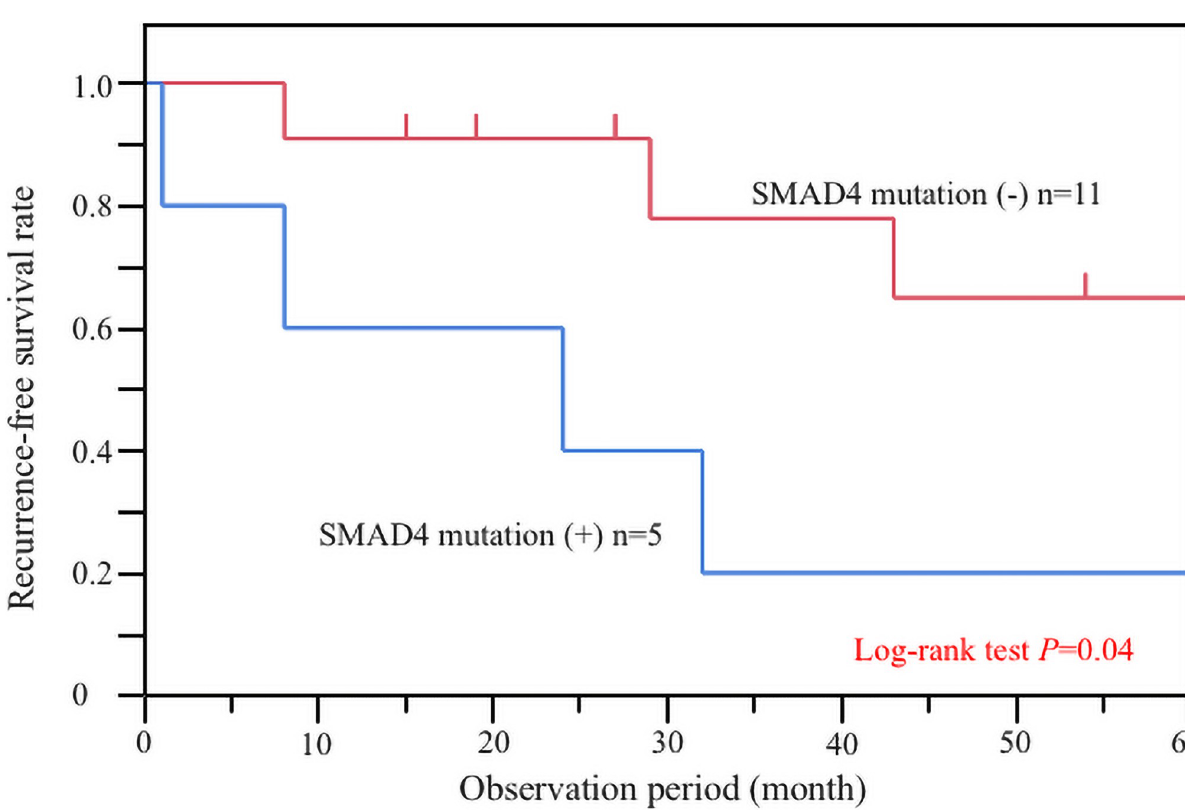
Fig 3. Analysis of recurrence-free survival (RFS) in patients with small-bowel cancer related to SMAD4 mutation. Patients with mutant SMAD4 had significantly poorer prognosis than those with wild-type SMAD4 ( P = 0.04). https://doi.org/10.1371/journal.pone.0241454.g003 Table 6. Univariate association with recurrence-free